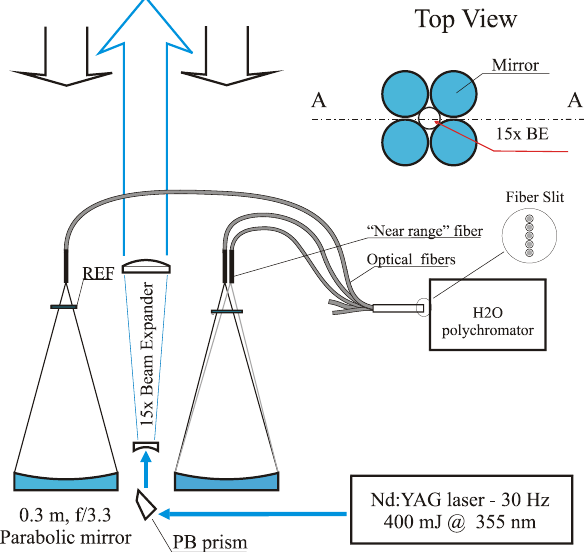
Fig. 1. Lidar optical scheme: A 15 × beam expander is centered be- tween four 30 cm in diameter, f/3.33 parabolic mirrors as illustrated by the top view shown in the upper right corner. The optical scheme is a cross section along the line A–A of the top view, therefore only two of the telescope mirrors can be seen; REF – Razor edge filter (Semrock ® ); PB – Pellin–Broca prism; PMT –